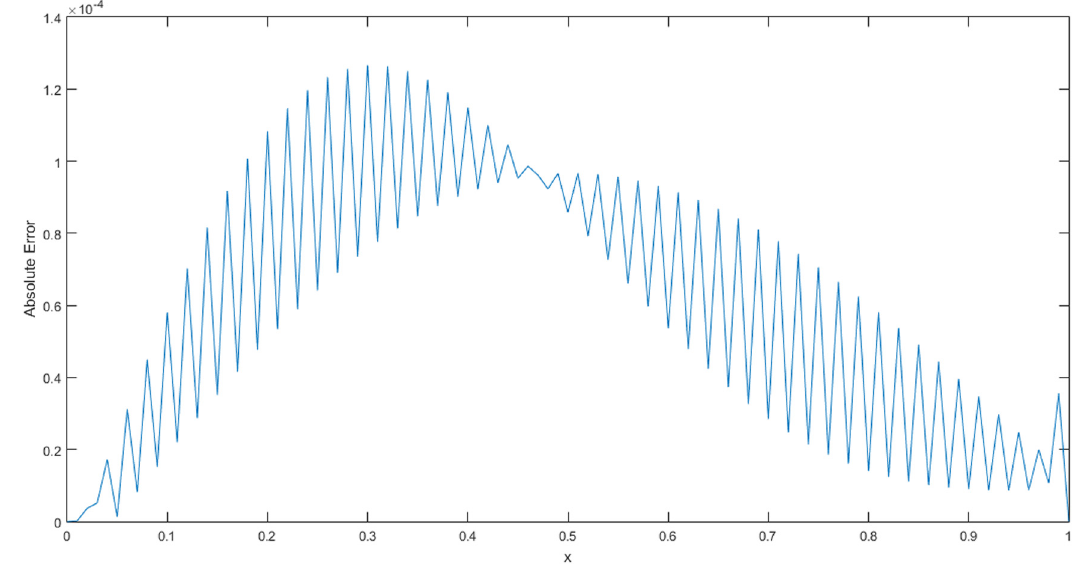
Figure 6: Absolute error at = t 0.0005 , = ν 0.001 , = α 10 , = N 101 , and = t Δ 0.0001 .